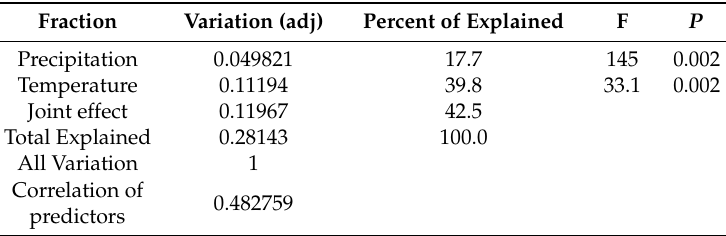
Table 1. RDA Results for the original data at regional scale.